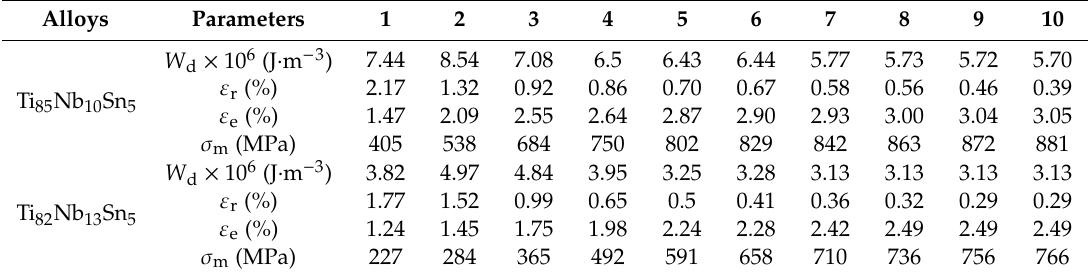
Table 2. The cyclic dissipation energy ( W d ), residual strain ( ε r ), elastic strain ( ε e ), and critical stress ( σ m ) of martensitic tranformation.